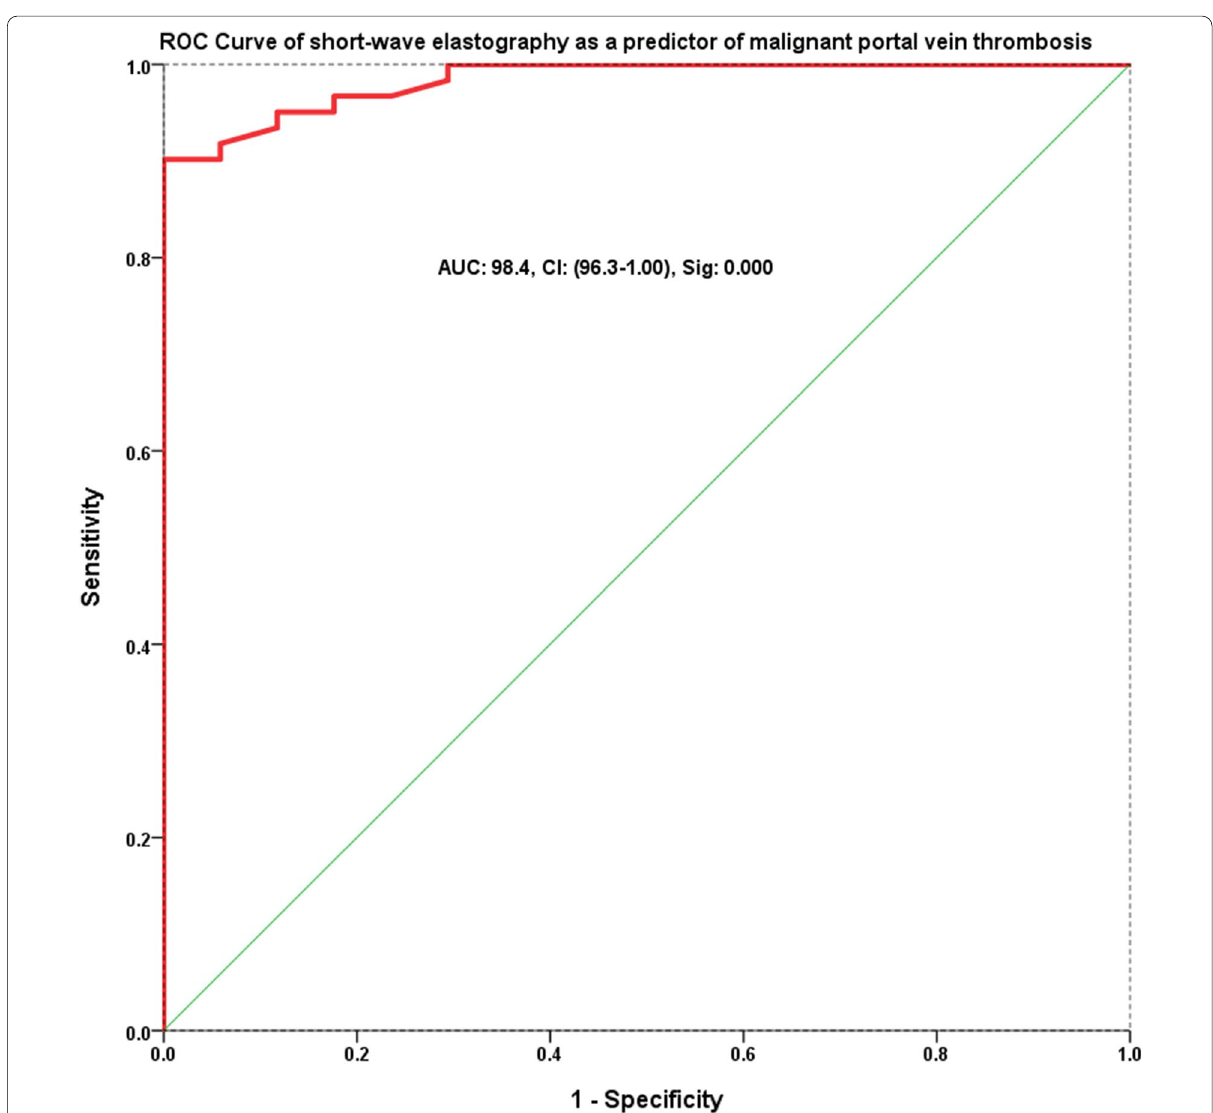
Fig. 4 ROC curve of short wave elastography as a predictor of malignant portal vein